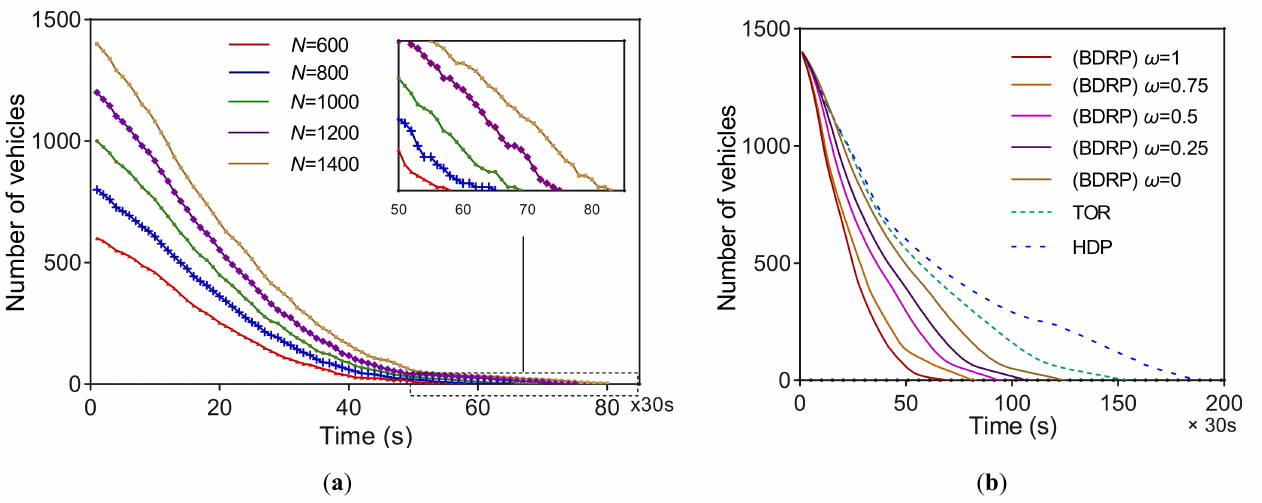
Figure 11. Traffic efficiency under different vehicle sizes and different weight parameters. ( a ) route- planning efficiency under different vehicle sizes ( ω = 0.5); ( b ) route-planning efficiency with different